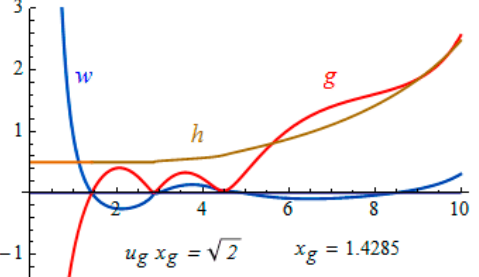
== xx of the max gg ux . gg